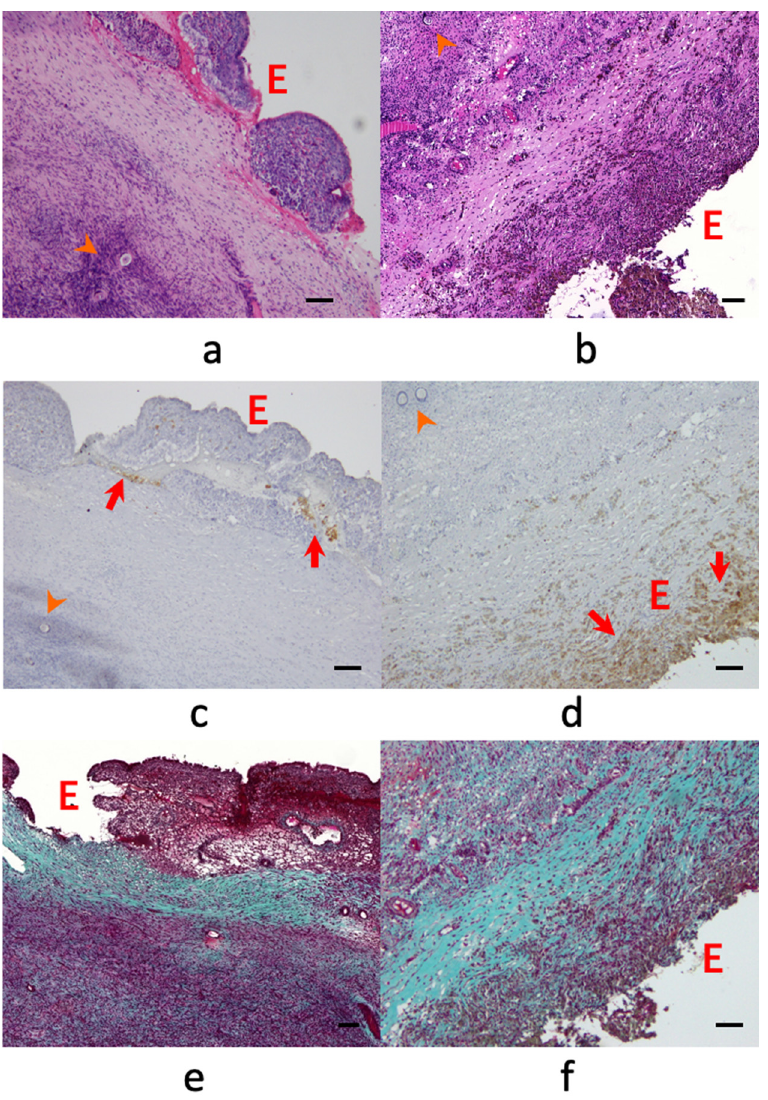
Figure 1. Histomorphological characteristics of ovarian endometriosis and adjacent normal ovarian tissue. Representative photomicrographs of superficial ovarian endometriosis ( a , c , e ) and cyst wall of ovarian endometrioma ( b , d , f ). Hematoxylin and eosin (H.E.) staining of superficial ovarian endometriosis ( a ) and cyst wall of ovarian endometrioma ( b ). Endometriotic lesions (E) are developed on the ovarian surface ( a ). Marked hemosiderin deposits are present beneath the endometriotic tissue lining (E) in the cyst wall ( b ). Detecting macrophage infiltration by CD68 immunohistochemistry ( c , d ). Among the endometriotic tissue, CD68 positive infiltrated cells (red arrows) were determined both in superficial lesions and the cyst wall of endometrioma. Tissue fibrosis were detected with a green color by Masson-trichrome staining ( e , f ). A fibrotic layer is formed between endometriotic lesions and normal a ovarian cortex ( e ). Dense fibrosis is evident in the cyst wall of ovarian endometrioma ( f ). Each bar indicates 100 µ